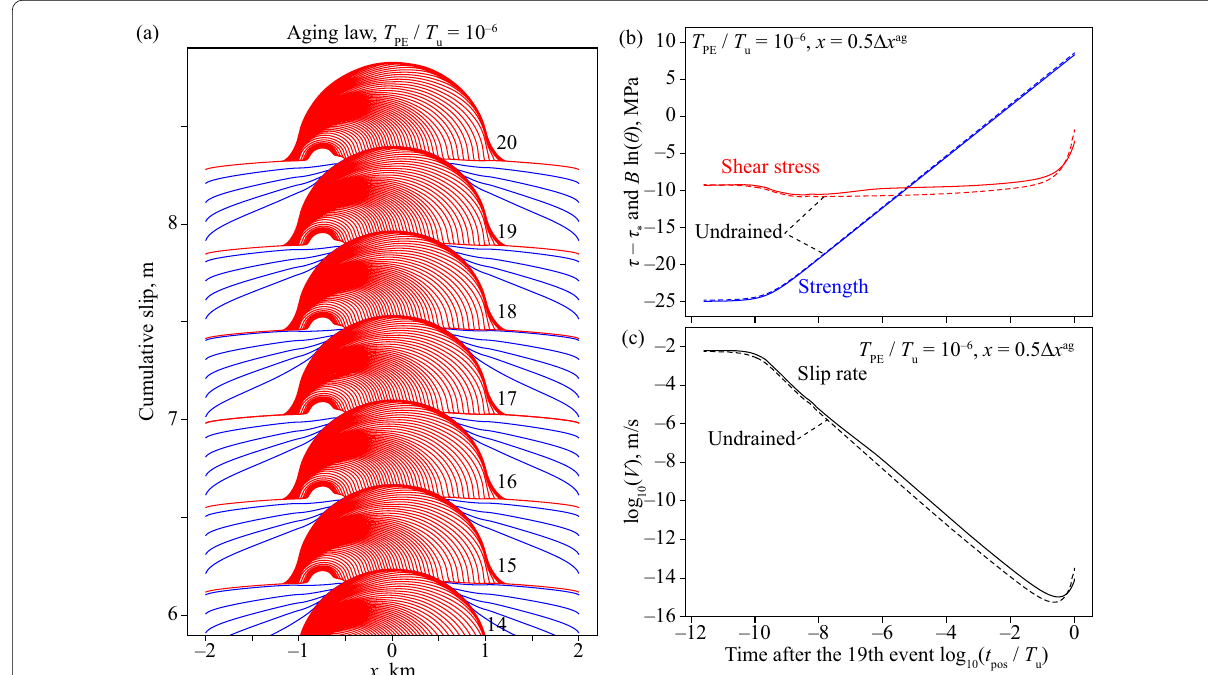
Fig. 6 Example simulation with PE for a fault governed by the aging law. a Cumulative slip distribution, blue: every 10 8 s , red: every 0.02s during earthquakes. Integers indicate ordinal numbers of earthquakes in the simulated sequence. b Shear stress (red) and strength (bule) of the fault relative to the reference at x = 0.5 � x ag = R / 256 as a function of time after the 19th earthquake. c Slip rate near the center, x = 0.5 � x ag = R / 256 as a function of time after the 19th